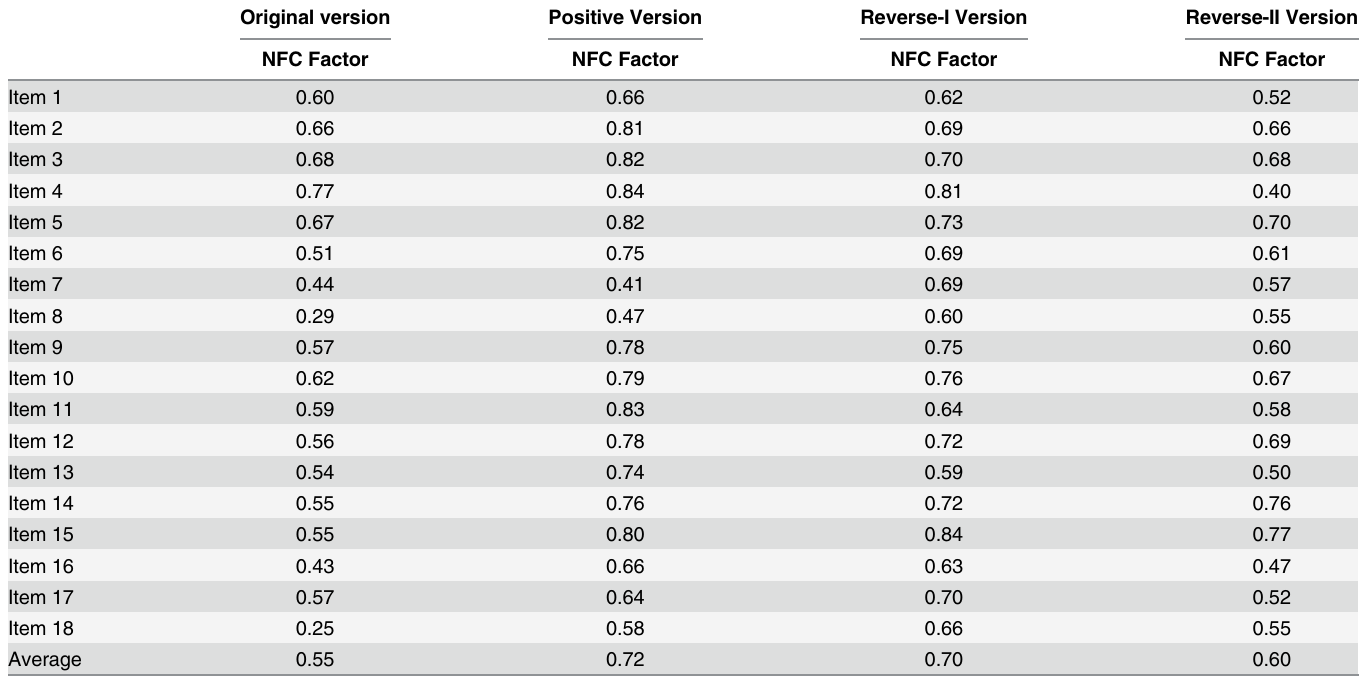
Table 4. Standardized Factor Loadings of Model 1 for the Four Scale